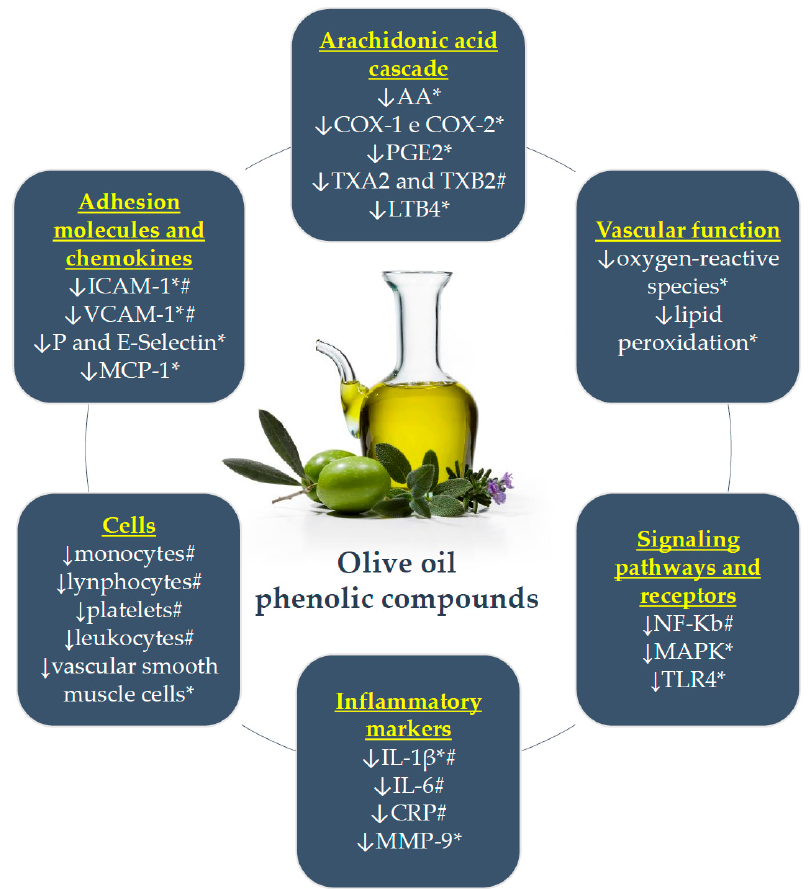
Figure 1. Main anti-inflammatory effects of olive oil phenolic compounds. *: in vitro or animal model; #: individuals at risk for CAD; ↓ : decreases or inhibits; AA: arachidonic acid; COX: cyclooxygenase; PGE2: prostaglandins E2; TX: thromboxane; LTB4: leukotriene B4; NF- κ B: nuclear factor kappa B; MAPK: mitogen-activated protein kinases; TLR: toll-like receptor; IL: interleukin; CRP: C-reactive protein; MMP-9: matrix metalloproteinase-9; ICAM-1: intercellular adhesion molecule-1; VCAM-1: vascular cell adhesion molecule-1; MCP-1: chemotactic monocyte